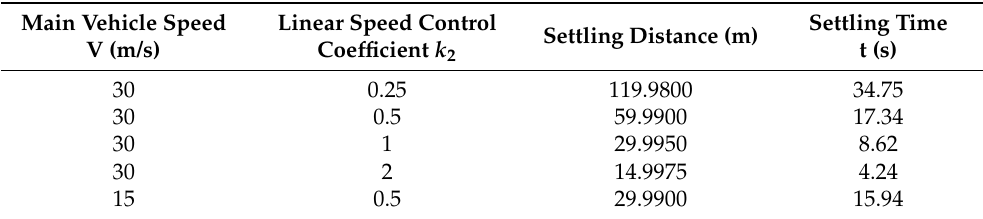
Table 1. Simulation results (angular velocity control coefficient k 1 = 4.0, initial distance between the two vehicles = 20 m, facing the same